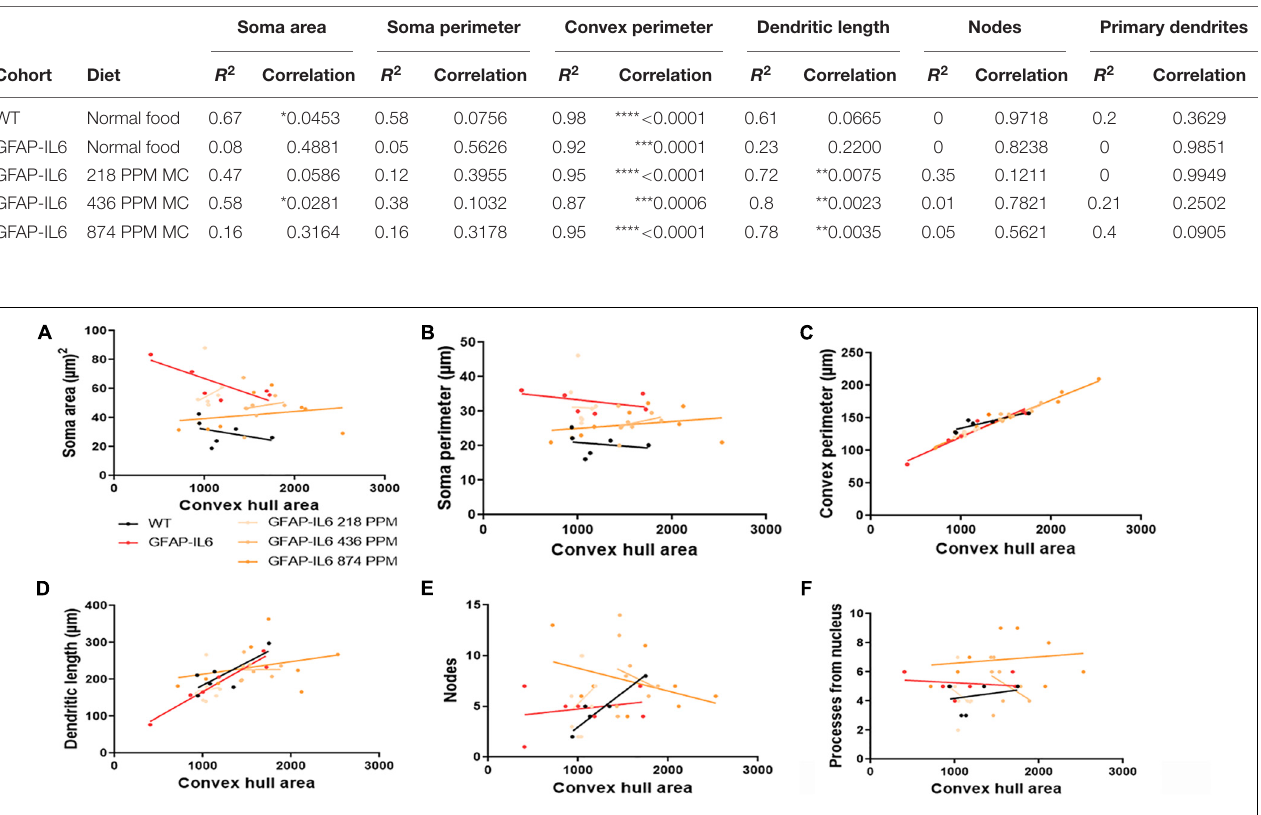
FIGURE 13 | Bivariate correlation: MC effects on morphology are dose-independent in the cerebellum. (A–F) Different morphological parameters have been plotted against convex hull area to see the bivariate correlation between the WT, GFAP-IL6 and between non-treated and treated ones. We found that medium and a high dose of MC showed a significant correlation in convex perimeter relative to convex hull area in cerebellum ANCOVA and sum-of-squares tests.